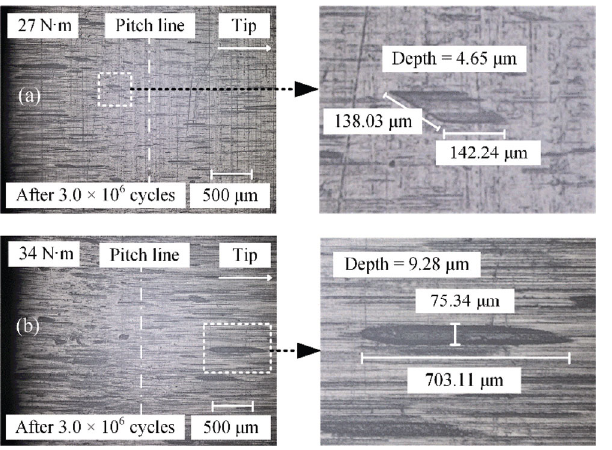
Fig. 19 Two typical scratch patterns under the oil-lubricated